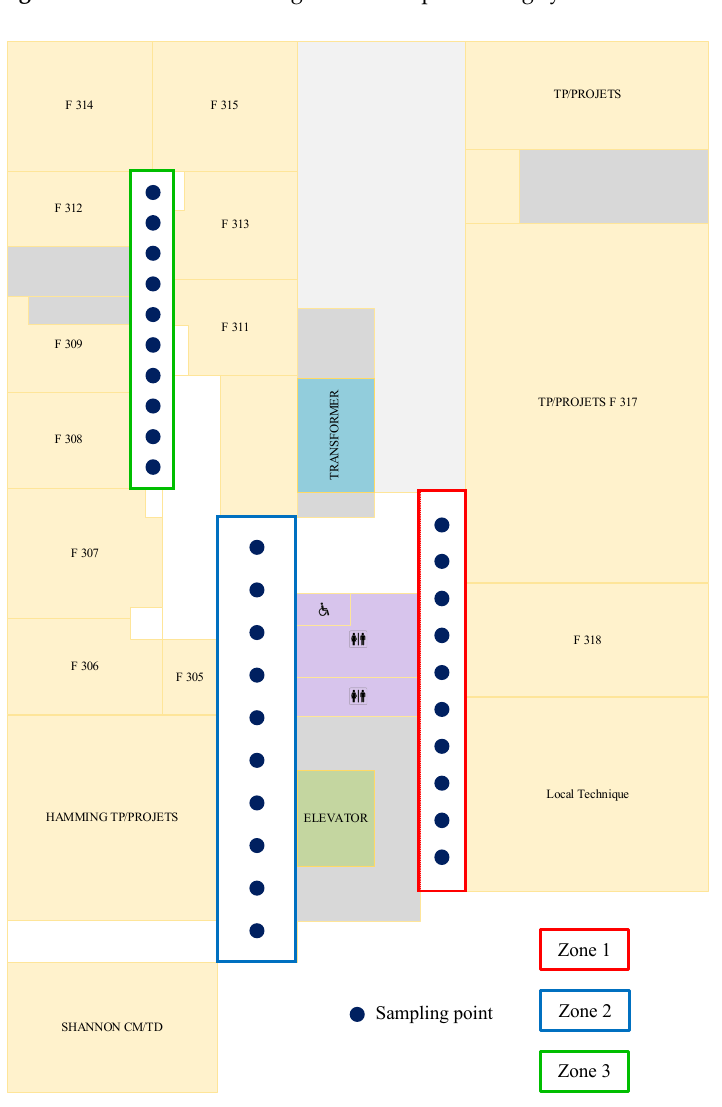
Figure 14. Building of Polytech Orléans—Galilée, Univ. of Orléans with test zone 1, 2 and